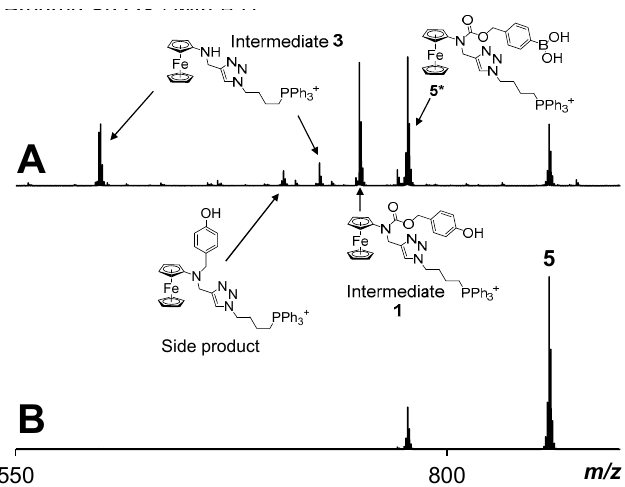
Figure 2. Mass spectra (electrospray ionization (ESI), positive mode) of prodrug 5 (40 μ M in N , N -dimethylformamide DMF/CH 3 CN/H 2 O, 1/10/90, v / v / v ) kept at 22 °C for 5 min in presence of H 2 O 2 (35 mM, inset A ) and in its absence (inset B ). More detailed information (e.g., zoomed in spectra) is provided in the SI (Figure S15).